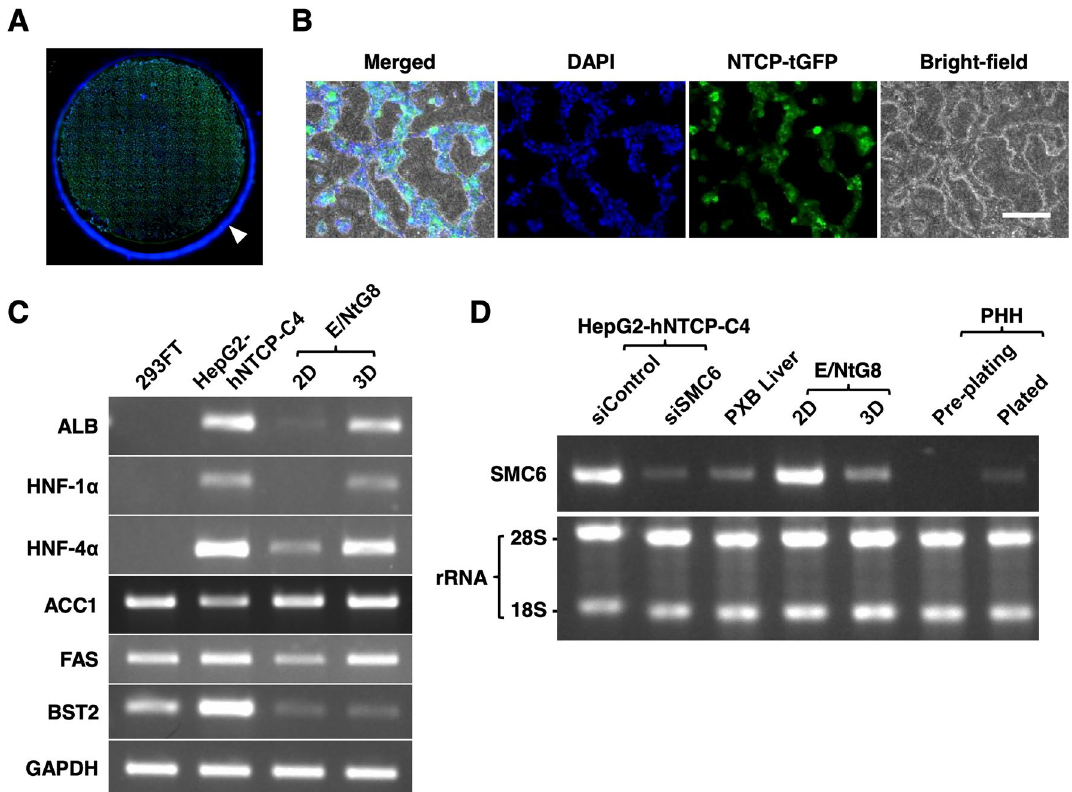
Figure 6. ( A ) Fluorescence imaging of E/NtG8 cells cultured on Cellbed for 7 days is shown. The image contains the overlay of NTCP-tGFP (shown in green) and DAPI-stained nuclei (shown in blue). The diameter of the Cellbed is about 13 mm. The arrowhead indicates a non-specific signal at the edge of the well. ( B ) Higher magnification image of panel ( A ). “Merged” represented the merged images of DAPI/NTCP-tGFP image and bright-field image. White scale bar, 200 µm. ( C ) The mRNA levels of the genes shown on the left of the panel. ALB, HNF-1α, HNF-4 α, ACC1, FAS, and BST-2 in 293FT cells, HepG2-hNTCP-C4 cells, E/NtG8 cells cultured in flat (2D) and 3D-cultured E/NtG8 (3D) cells were semi-quantified by RT-PCR. GAPDH used as an internal control. Full-length gel images were presented in Supplemental Figs. Fig. S10–Fig. S13. ( D ) Expression of SMC6 mRNA in siControl-transfected HepG2-hNTCP-C4, siSMC6-transfected HepG2-hNTCP-C4, PXB mouse liver, 2D-cultured E/NtG8 (2D) and 3D-cultured E/NtG8 (3D) cells, pre-plated cryopreserved human hepatocytes (pre-plating) and human hepatocytes plated and cultured for 48 h (Plated) were evaluated by RT-PCR. 28S and 18S rRNA used as internal and quality controls for each sample of 1 µg total RNA. Full-length gel images were presented in Supplemental Figs. Fig. S14 and Fig.